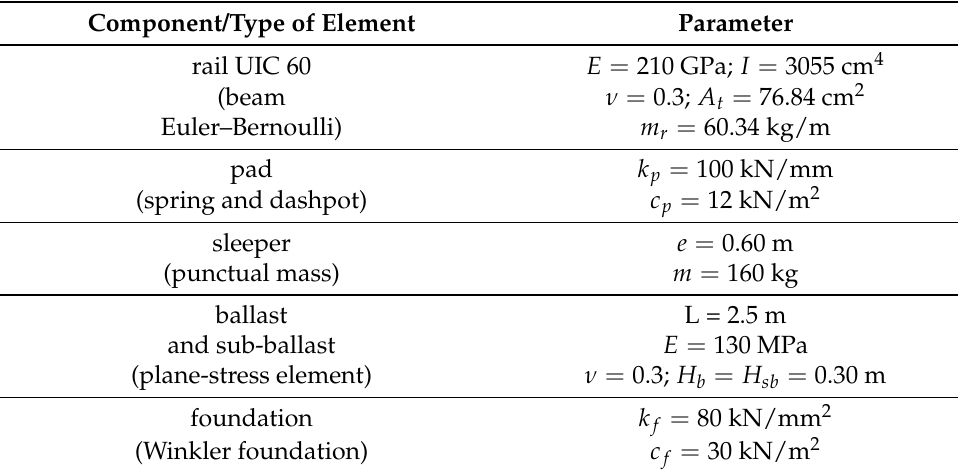
Table 1. Geometrical and mechanical characteristics of the ballasted track